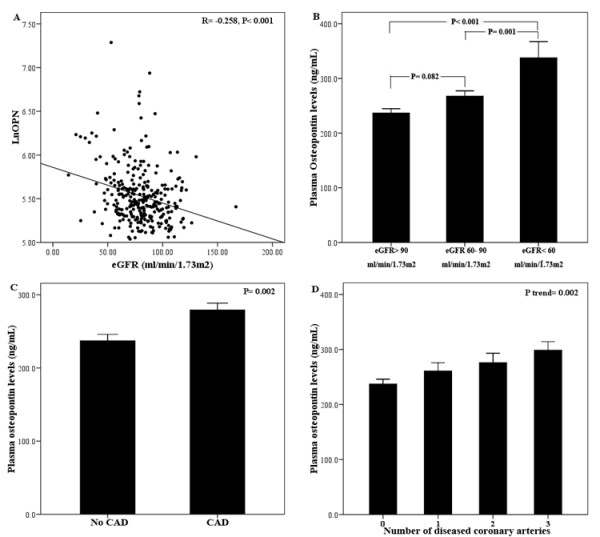
Association between plasma osteopontin (OPN) levels and renal insufficiency and coronary artery (CAD) disease in all diabetic patients. (A) Scatter plot showing the relationship between OPN and estimated glomerular filtration rate (eGFR) in the diabetic population. OPN concentrations were log-transformed and R represents Pearson's correlation coefficient. (B) Plasma OPN levels in patients with different renal function stratified according to eGFR. Data are the mean ± SEM. Differences among groups were analyzed by one-way ANOVA followed by post hoc analysis (with Bonferroni's correction). (C, D) Relationship between plasma OPN levels and the presence (C) and severity (D) of CAD in diabetes. Data are the mean ± SEM.